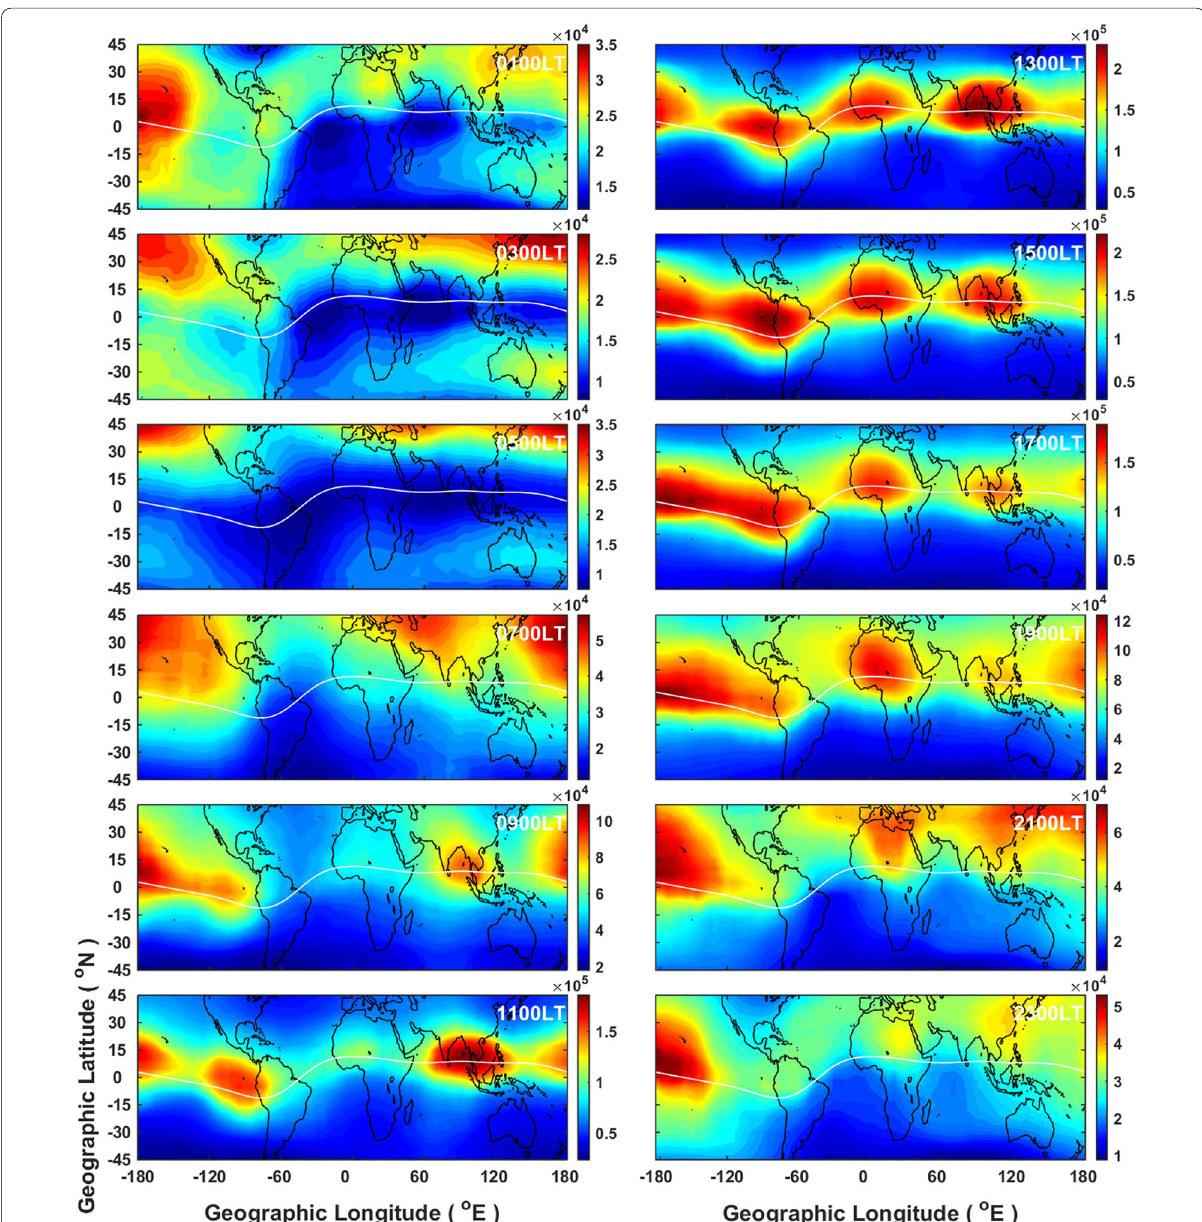
Fig. 4 Diurnal variations of F3/C electron density maps at 450‑km altitude at various global fixed local times in September 2008. It is noted that the color contour levels are varying in different subplots in order to clearly show the four‑peaked structure. The binning method is same as that used for Fig.